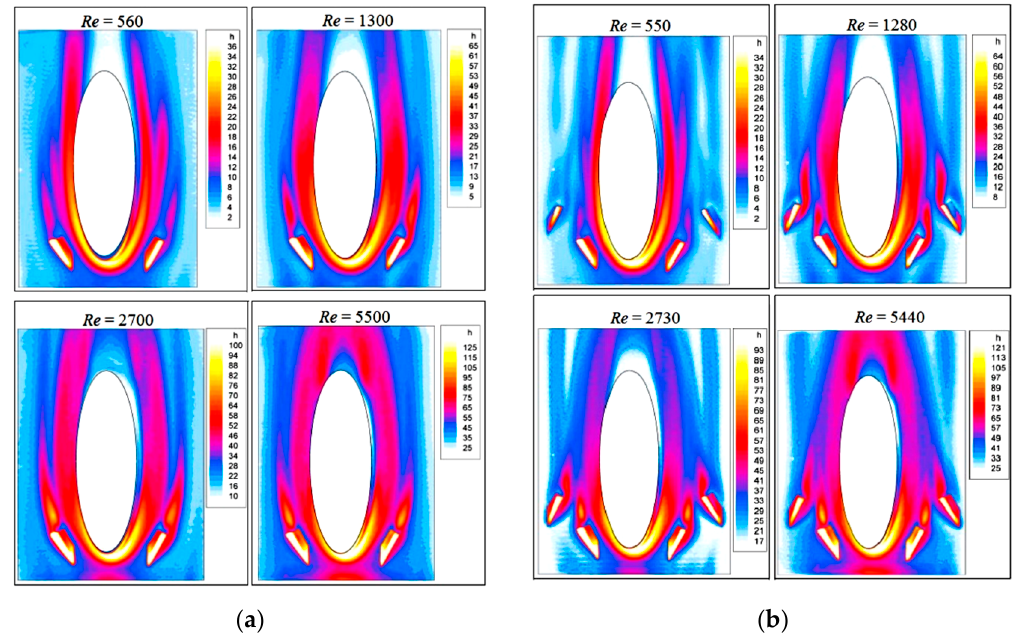
Figure 17. Local fin surface heat transfer coefficients for an oval tube with VGs [40]. ( a ) With a single winglet pair. ( b ) With two pairs of delta winglets in a staggered configuration.